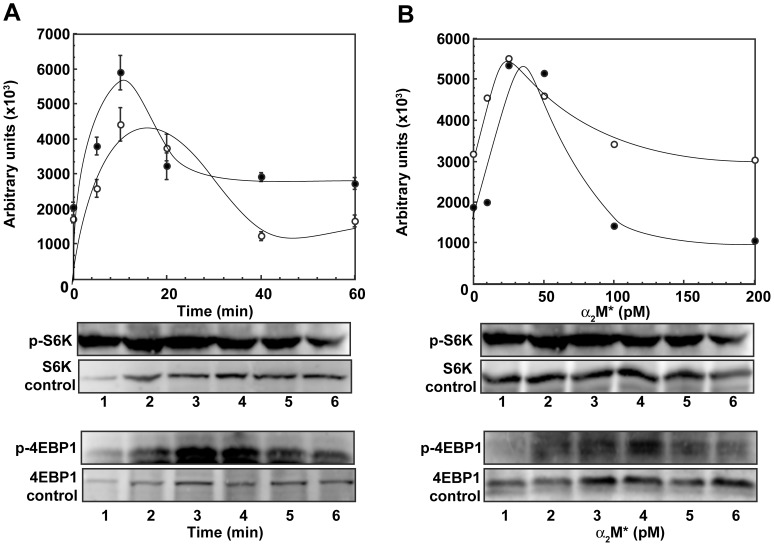
Effect of treatment of 1-LN prostate cancer cells with α2M* for varying periods of time (Panel A) or concentration (Panel B) on expression of p-S6-Kinase and p-4EBP1, as determined by Western blotting.A representative immunoblot of p-S6-Kinase (O) and p-4EBP1 (•) from three to five experiments is shown for each protein in Panels A and B. p-S6-Kinase (O) and p-4EBP1 (•) are expressed in arbitrary fluorescence units as the means ± SE from three to four independent experiments. The protein loading control for Panel A and Panel B are shown below the respective immunoblots.